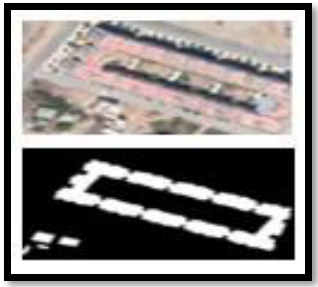
Fig. 3. One binary building mask generation